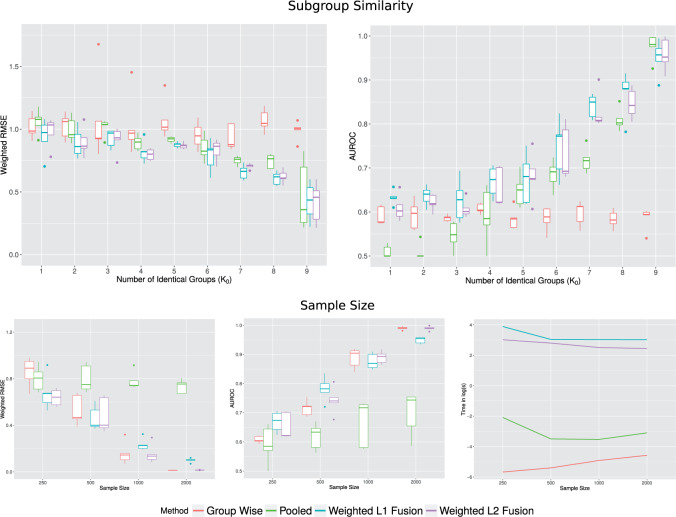
Simulated data performance. Top row: Varying \documentclass[12pt]{minimal}
\usepackage{amsmath}
\usepackage{wasysym}
\usepackage{amsfonts}
\usepackage{amssymb}
\usepackage{amsbsy}
\usepackage{upgreek}
\usepackage{mathrsfs}
\setlength{\oddsidemargin}{-69pt}
\begin{document}
}{}$K_0$\end{document}, where the number of subgroups is fixed at \documentclass[12pt]{minimal}
\usepackage{amsmath}
\usepackage{wasysym}
\usepackage{amsfonts}
\usepackage{amssymb}
\usepackage{amsbsy}
\usepackage{upgreek}
\usepackage{mathrsfs}
\setlength{\oddsidemargin}{-69pt}
\begin{document}
}{}$K=9$\end{document} of which \documentclass[12pt]{minimal}
\usepackage{amsmath}
\usepackage{wasysym}
\usepackage{amsfonts}
\usepackage{amssymb}
\usepackage{amsbsy}
\usepackage{upgreek}
\usepackage{mathrsfs}
\setlength{\oddsidemargin}{-69pt}
\begin{document}
}{}$K_0$\end{document} have shared coefficients in the underlying data-generating model (see text for details of simulation set-up). A smaller \documentclass[12pt]{minimal}
\usepackage{amsmath}
\usepackage{wasysym}
\usepackage{amsfonts}
\usepackage{amssymb}
\usepackage{amsbsy}
\usepackage{upgreek}
\usepackage{mathrsfs}
\setlength{\oddsidemargin}{-69pt}
\begin{document}
}{}$K_0$\end{document} corresponds to less similarity between underlying subgroup-specific models, with \documentclass[12pt]{minimal}
\usepackage{amsmath}
\usepackage{wasysym}
\usepackage{amsfonts}
\usepackage{amssymb}
\usepackage{amsbsy}
\usepackage{upgreek}
\usepackage{mathrsfs}
\setlength{\oddsidemargin}{-69pt}
\begin{document}
}{}$K_0=1$\end{document} representing the case where all subgroups have separately drawn coefficients, while \documentclass[12pt]{minimal}
\usepackage{amsmath}
\usepackage{wasysym}
\usepackage{amsfonts}
\usepackage{amssymb}
\usepackage{amsbsy}
\usepackage{upgreek}
\usepackage{mathrsfs}
\setlength{\oddsidemargin}{-69pt}
\begin{document}
}{}$K_0=9$\end{document} represents an entirely homogenous model in which each subgroup has exactly the same regression coefficients. The total sample size is fixed at \documentclass[12pt]{minimal}
\usepackage{amsmath}
\usepackage{wasysym}
\usepackage{amsfonts}
\usepackage{amssymb}
\usepackage{amsbsy}
\usepackage{upgreek}
\usepackage{mathrsfs}
\setlength{\oddsidemargin}{-69pt}
\begin{document}
}{}$n=250$\end{document}. Left panel: Weighted root mean squared error (RMSE). RMSE is weighted by subgroup sizes. Right panel: Area under the ROC curve (AUROC) with respect to the true sets of active variables with non-zero coefficients). Bottom Row: Varying sample sizes, where the number of subgroups is fixed at \documentclass[12pt]{minimal}
\usepackage{amsmath}
\usepackage{wasysym}
\usepackage{amsfonts}
\usepackage{amssymb}
\usepackage{amsbsy}
\usepackage{upgreek}
\usepackage{mathrsfs}
\setlength{\oddsidemargin}{-69pt}
\begin{document}
}{}$K=9$\end{document} of which \documentclass[12pt]{minimal}
\usepackage{amsmath}
\usepackage{wasysym}
\usepackage{amsfonts}
\usepackage{amssymb}
\usepackage{amsbsy}
\usepackage{upgreek}
\usepackage{mathrsfs}
\setlength{\oddsidemargin}{-69pt}
\begin{document}
}{}$K_0=4$\end{document} have shared coefficients in the underlying data-generating model (see text for details of simulation set-up). Left panel: Root mean squared error (RMSE; weighted by subgroup sizes). Middle panel: Area under the ROC curve (AUROC); with respect to the true sets of active variables with non-zero coefficients. Right panel: Computational time taken in log seconds.